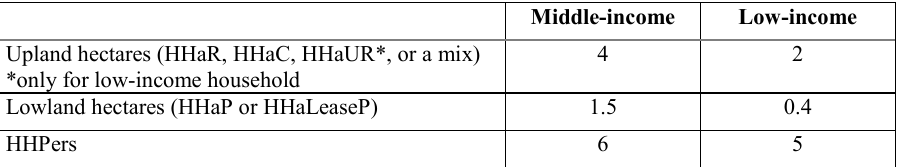
Table A1.3-C: Values of household variables instantiated in the BN to represent low-income and middle-income households across case study